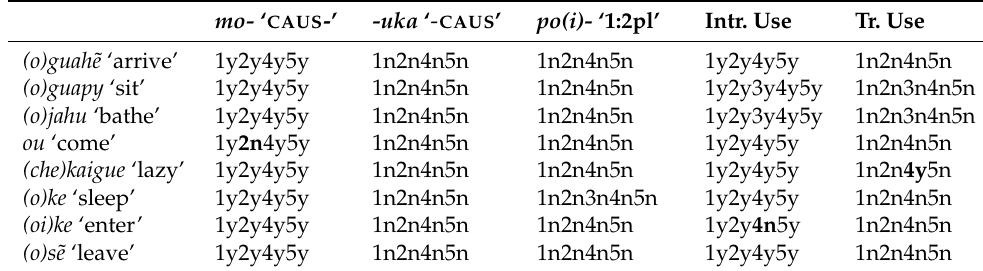
Table A2. Judgments for verbs that pattern like intransitive verbs. mo- ‘ CAUS -’ -uka ‘ - CAUS ’ po(i)- ‘1:2pl’ Intr. Use Tr.